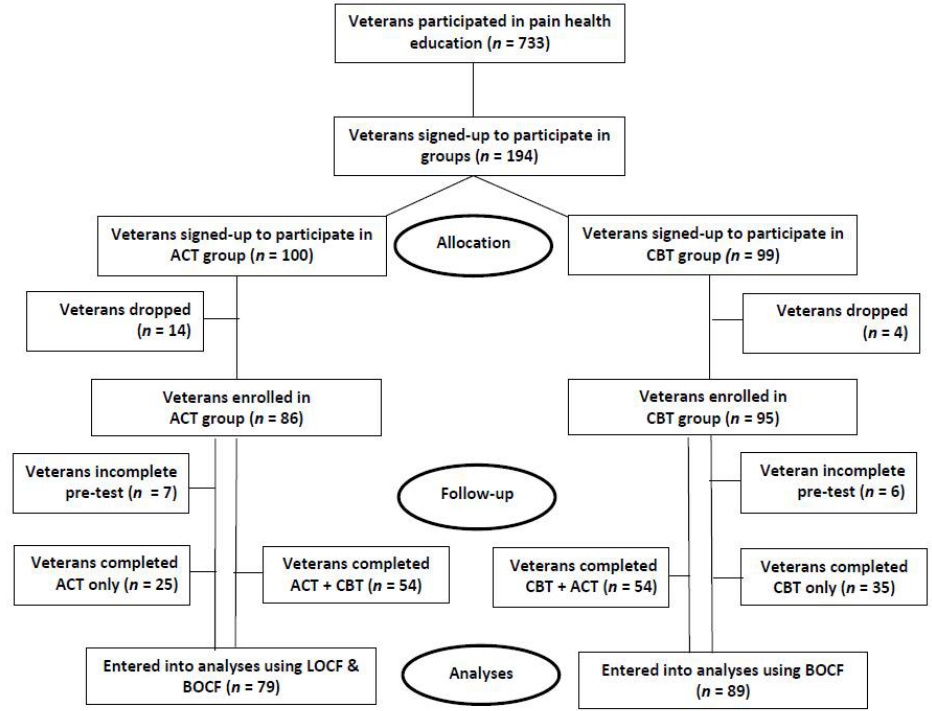
Figure 2. Flowchart of study participants.